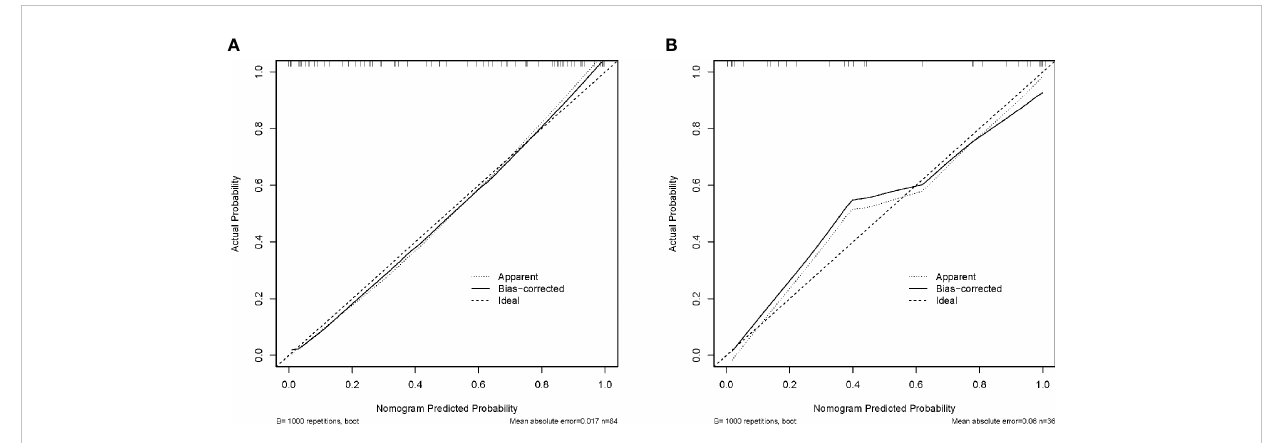
FIGURE 7 Calibration curves of the nomogram in the training (A) and validation (B)